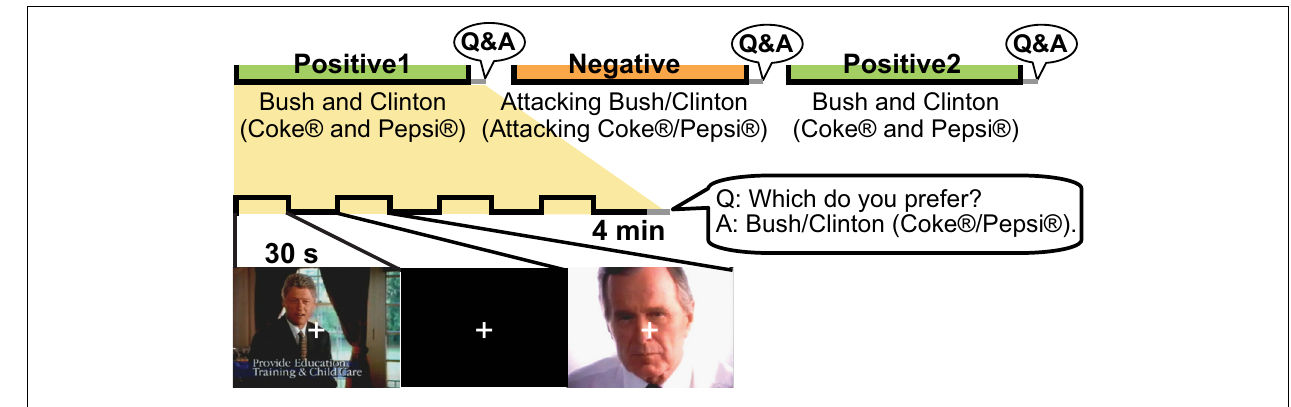
FIGURE 1 | Tasks inside the MR machine. Three sessions of campaign advertisements and three sessions of cola advertisements were shown. After each session, the participants were asked which of the two candidates/brands they favoured. For both the campaign and cola advertisements, the fi rst session consisted of positive advertisements for both candidates/brands. The candidate/